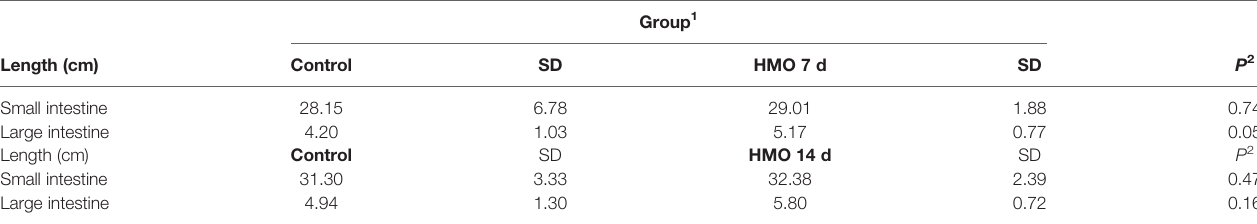
TABLE 1 | Intestinal length for germ-free mice used as control compared to the HMO groups at 28 or 35 days of